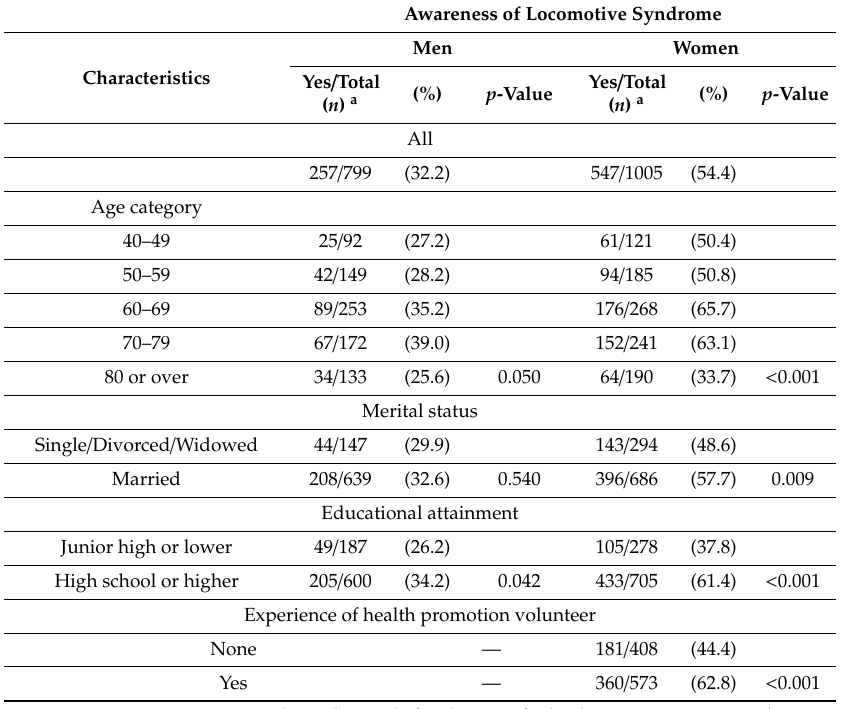
Table 1. Participant characteristics by sex, in association with the awareness of locomotive syndrome.